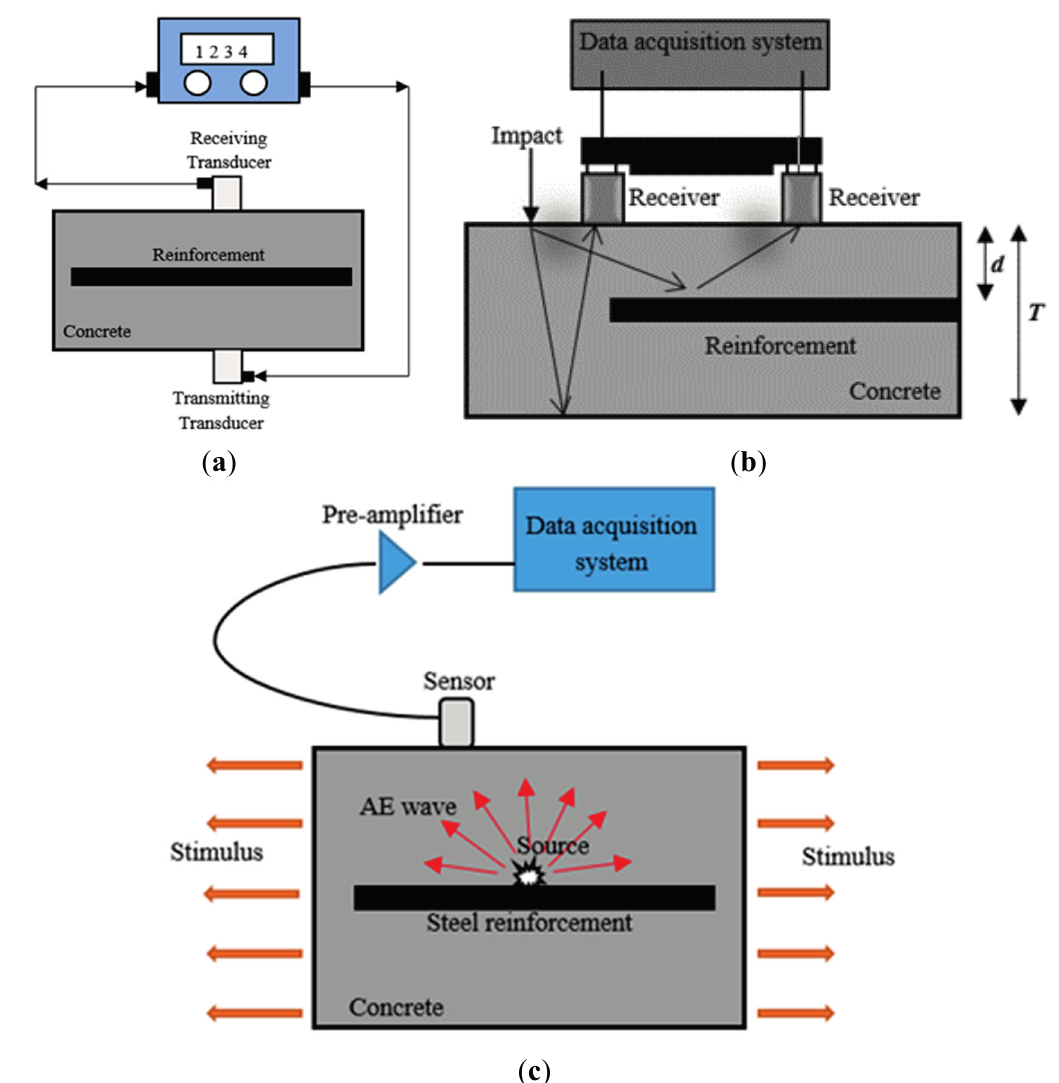
Figure 3. The principle of: ( a ) ultrasonic pulse velocity (Reproduced and modified from [120]); ( b ) impact echo (Reproduced and modified from [121]); and ( c ) acoustic emission (Reproduced and modified from